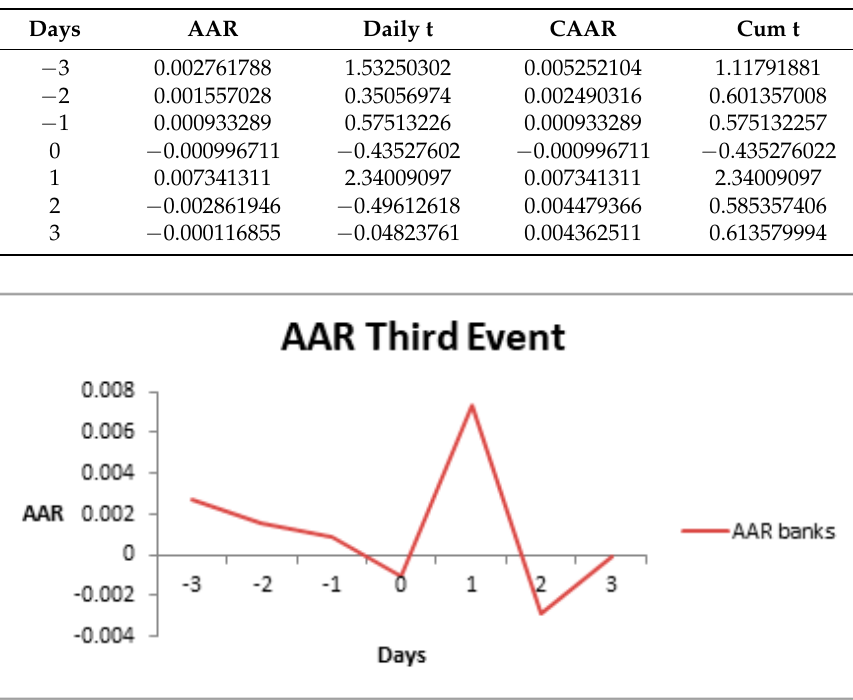
Figure 6. Average Abnormal Return (AAR) for banks. Source: Authors’ work.